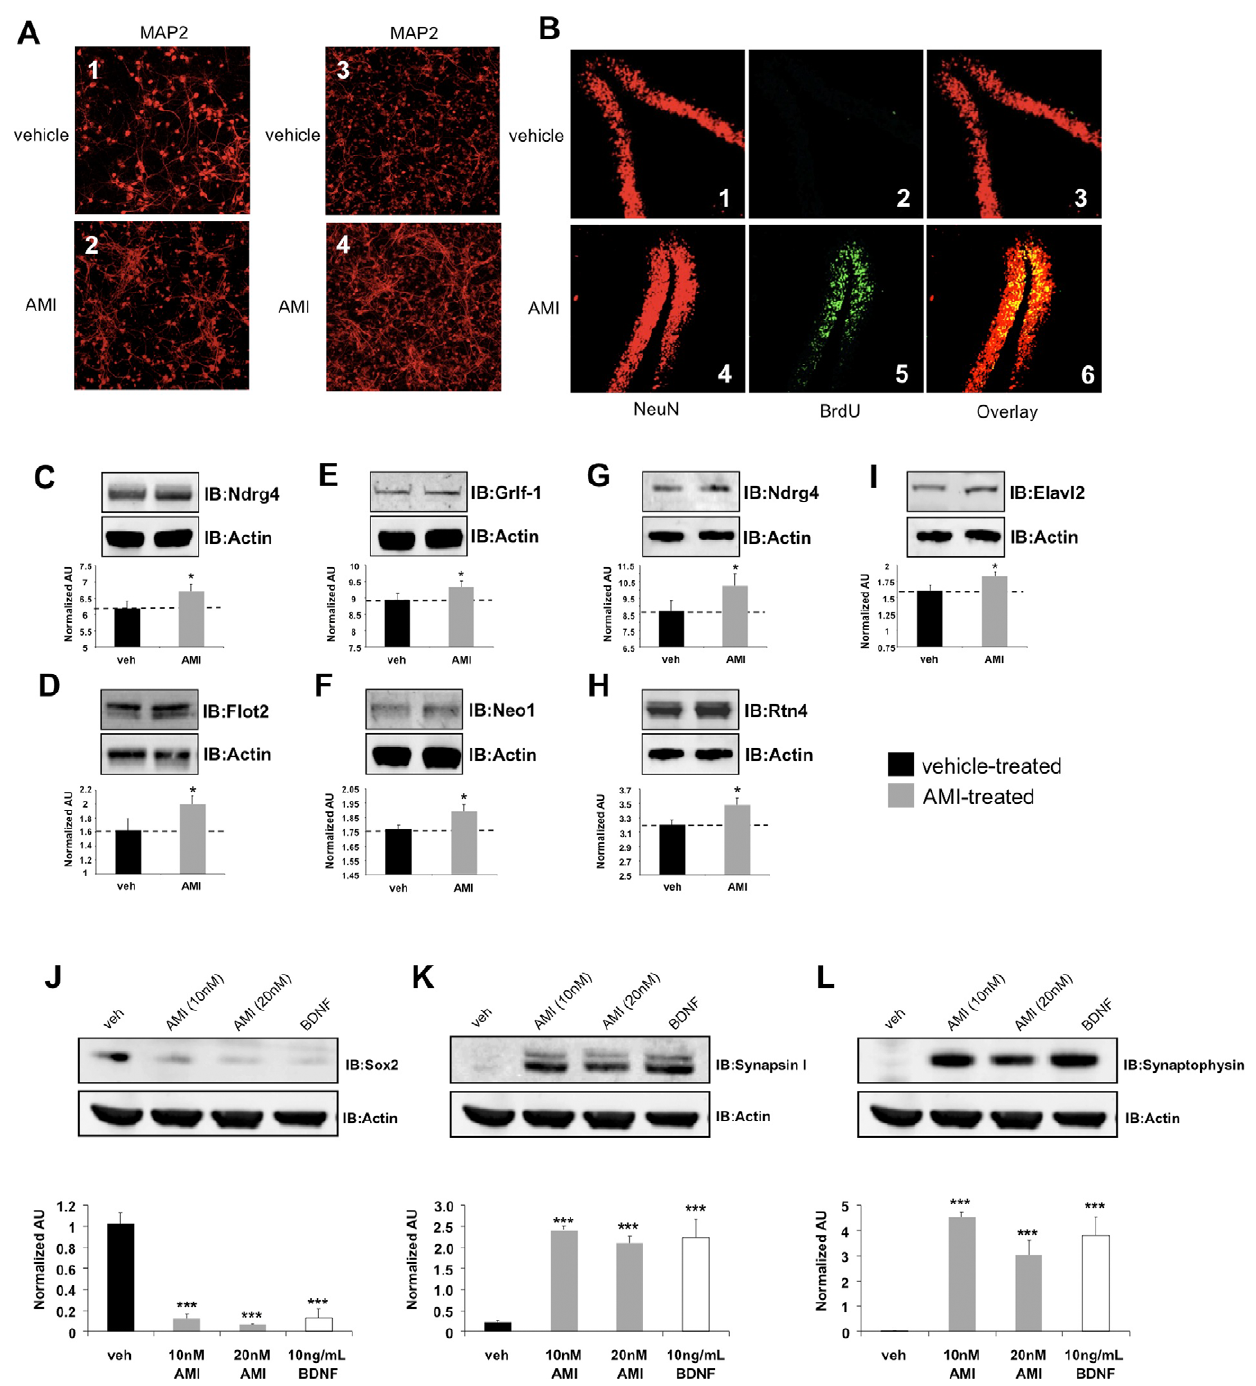
Figure 5. AMI activates neuronal developmental processes. (A) AMI (10 nM, 72 hrs) effect upon primary hippocampal (veh-treated, 1: AMI- treated, 2) and cortical (veh-treated, 3: AMI-treated, 4) cell morphology, indicated with anti-MAP2 immunoreactivity. (B) AMI/veh effects upon adult neurogenesis in hippocampal DG (veh: NeuN-1, BrdU-2, overlay-3; AMI: NeuN-4, BrdU-5, overlay-6). AMI-mediated alterations of hippocampal Ndrg4 (C), Flot2 (D), Grlf1 (E) and Neo1 (F) expression. AMI-mediated alterations of cortical Ndrg4 (G), Rtn4 (H) and Elavl2 (I) expression. Western band intensities were quantified as actin-normalized arbitrary absorbance units (AU:n=3 individual experiments per protein assessed). Two week treatment of murine neural progenitor cells with AMI (10–20 nM: grey bars) or BDNF (10 ng/mL: white bars) affects Sox2 (J), synapsin I (K) and synaptophysin (L) expression, compared to vehicle treated (black bars) cells. The associated histograms depict the mean 6 SEM western band intensity (normalized AU) data from three independent experiments.